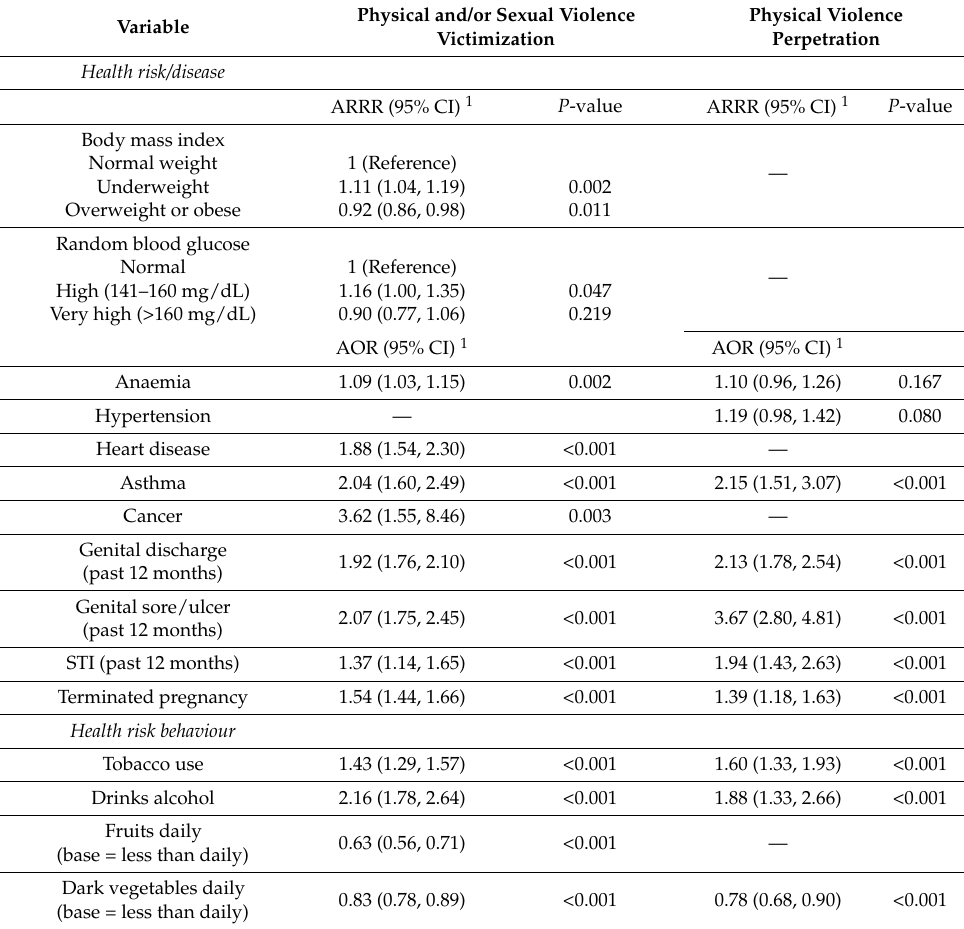
Table 3. Multivariable risk or odds ratios (with 95% confidence intervals) for health outcomes. Predictors: Physical and/or sexual violence victimization and physical violence perpetration (model N =